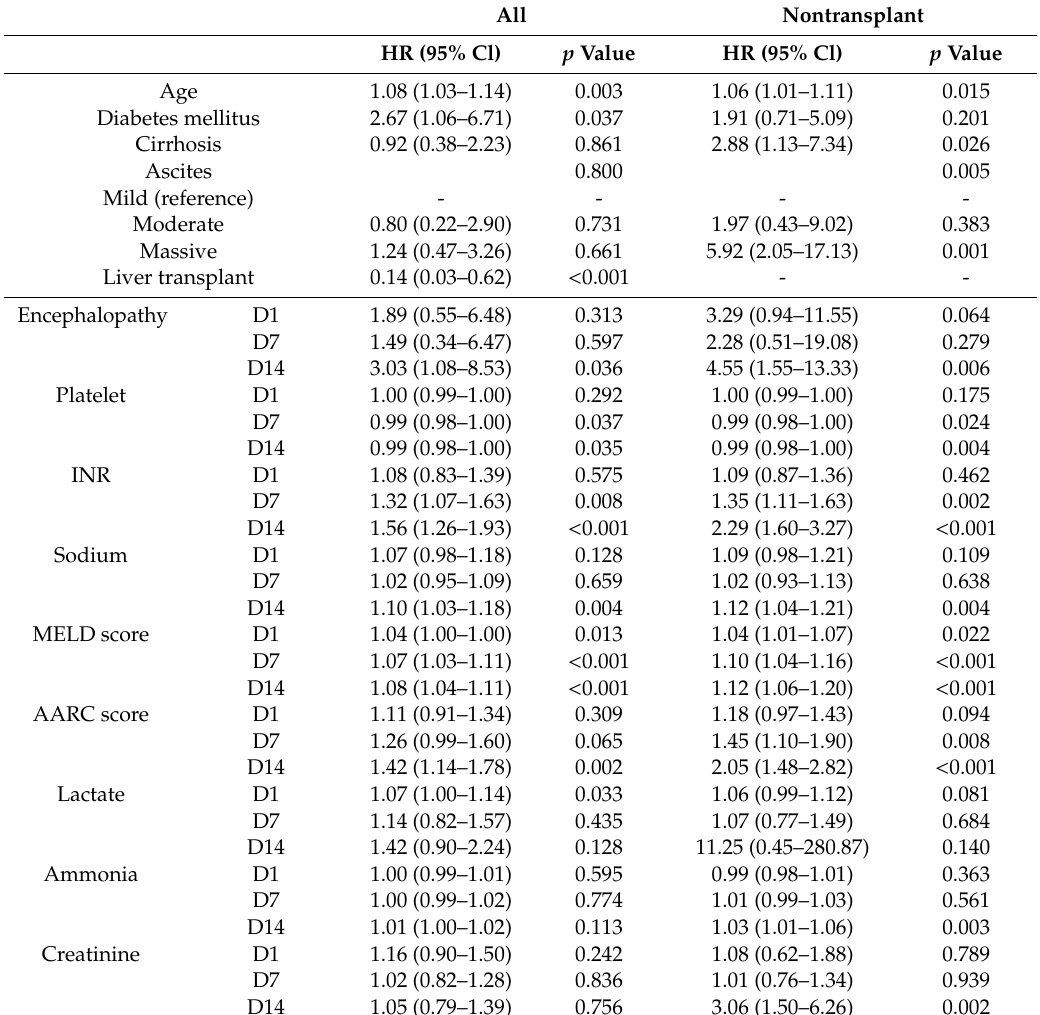
Table 3. Univariable risk factors associated with overall